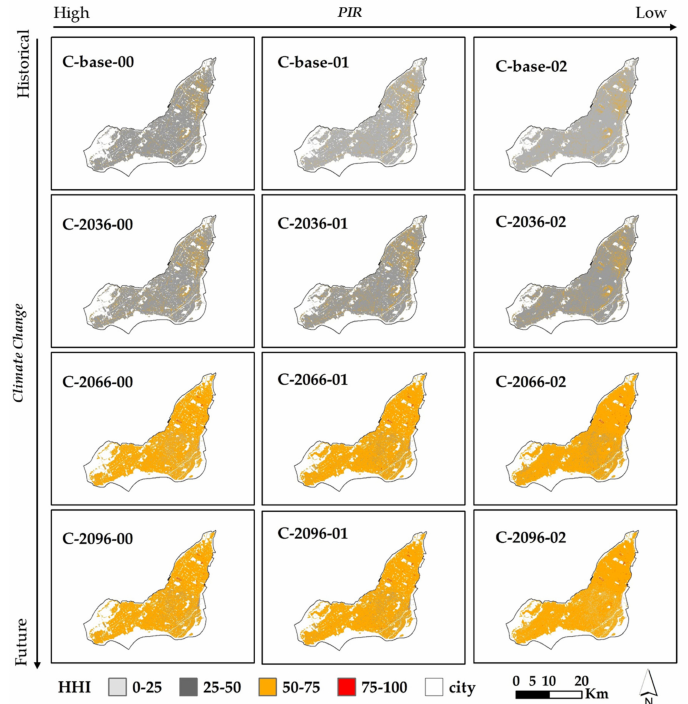
Figure 6. The HHI maps for Montreal under di ff erent climate (base year, 2036, 2066, and 2096) and land cover scenarios (base, Scenario 1, and Scenario